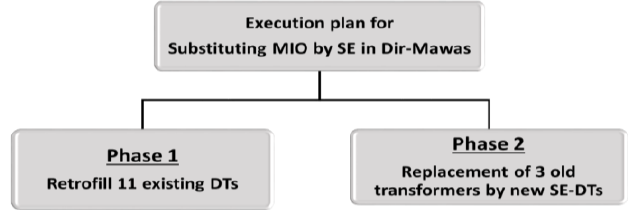
Figure 12. The execution plan for substituting MIO by SE in